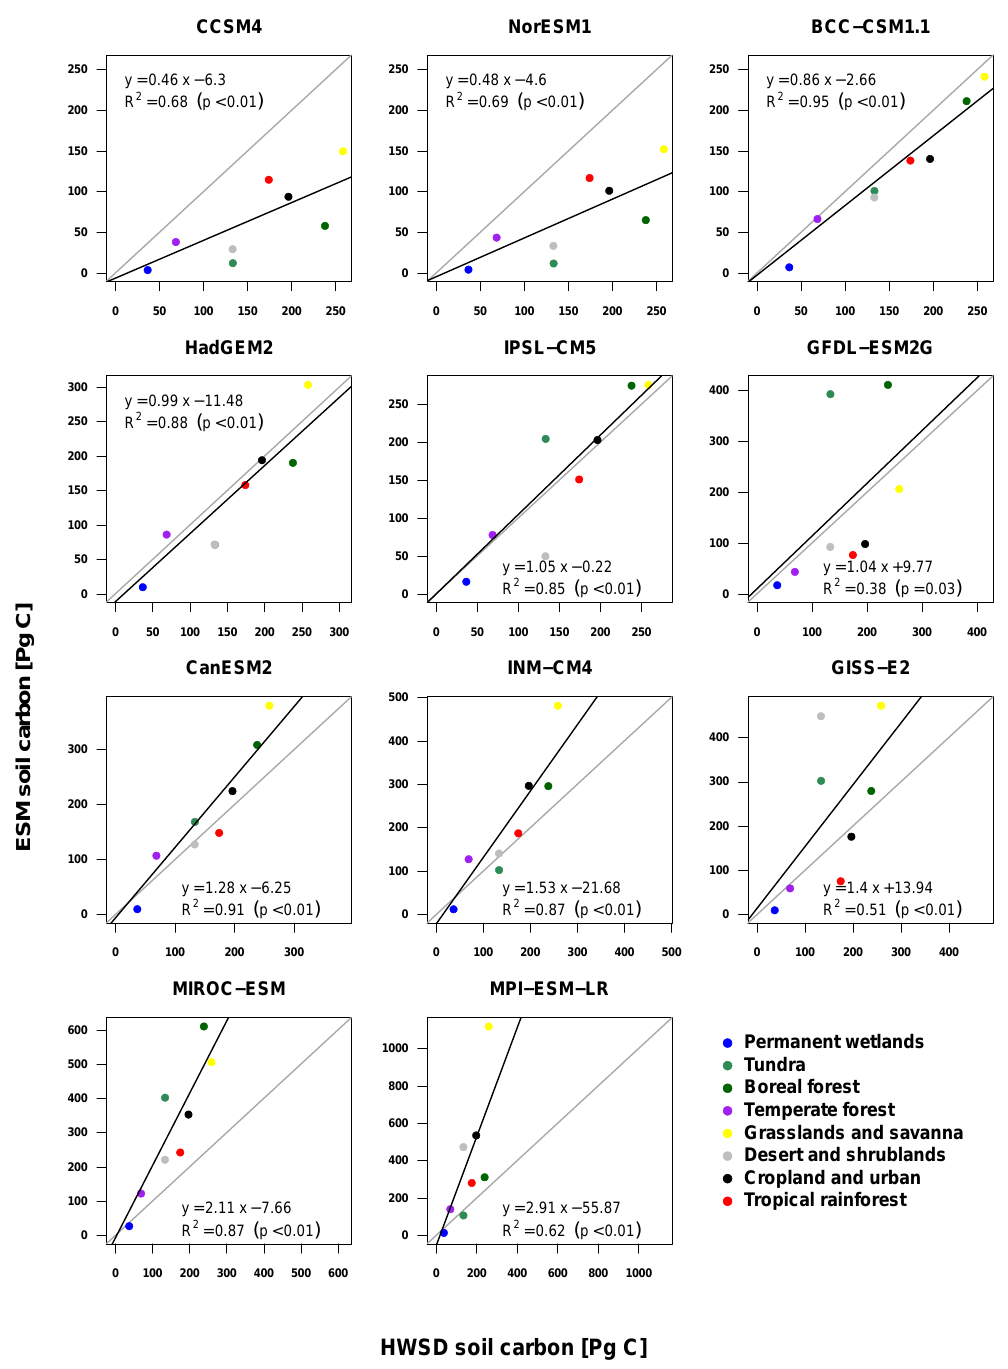
Fig. 4. Linear regression of ESM versus HWSD soil carbon totals [PgC] for the 8 major biomes. The gray line indicates a 1 : 1 relationship and the black line is the linear